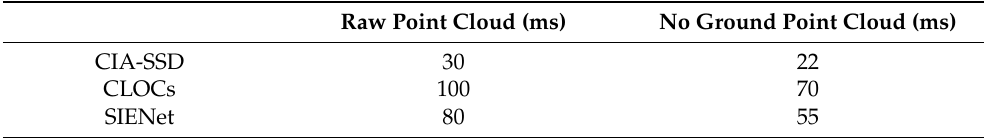
Table 4. Comparison of efficiency before and after ground